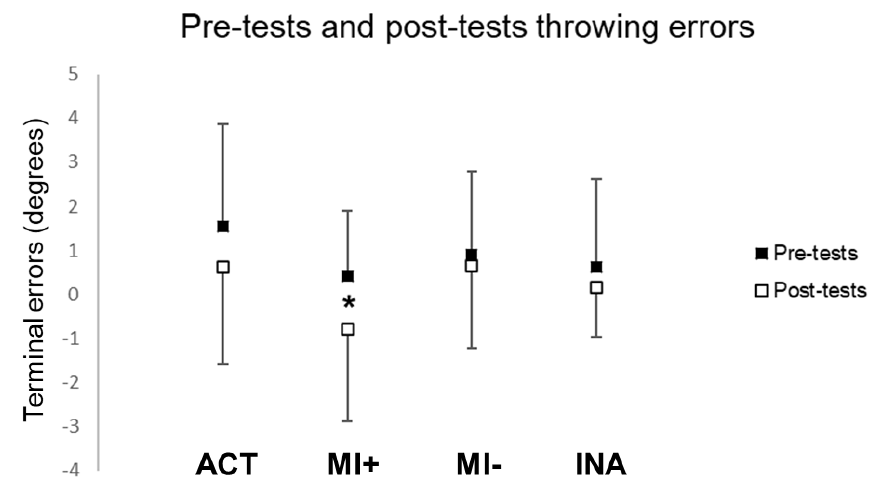
Figure 4. Throwing terminal errors during pre and post-tests. Values are reported with standard deviations. * means significance at p < 0.05. ACT: active group; MI: motor imagery groups with higher (+) versus lower ( − ) MI abilities; INA: inactive group.